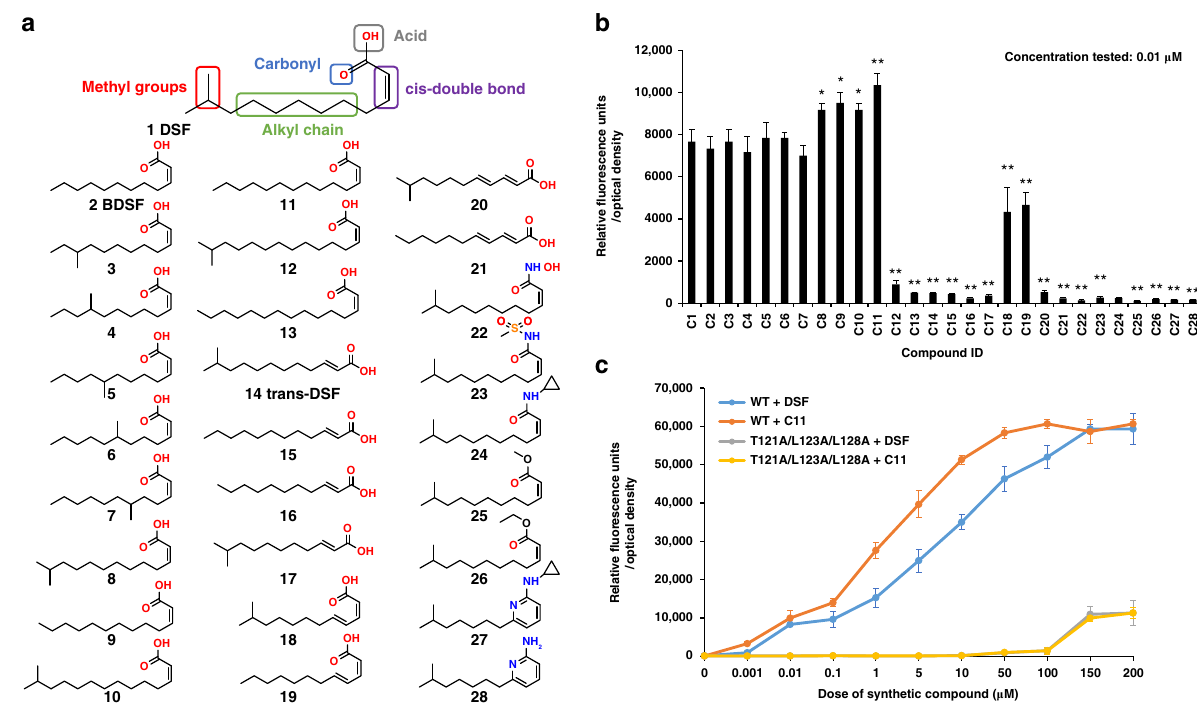
Fig. 2 Diffusible signal factor (DSF) analog testing reveals features needed for perception by PA1396. a The structure of DSF ( cis -11-methyl-2-dodecenoic acid) highlighting structural elements. Below this are the chemical structures of the 27 synthetic derivatives of DSF, all validated by ESI-MS and 1 H NMR spectra as described in the Methods. b The biological activity of DSF and its derivatives in activation of the pmr-gfp fusion. Samples were tested at a concentration of 0.01 µ M (the minimum concentration of cis -11-methyl-2-dodecenoic acid required for activation of the bioassay). Values are the average of three technical repeats (mean ± standard deviation). Asterisks indicate values that are signi fi cantly different from the appropriate wild type ( p < 0.05, Student's t- test). c Dose – response of DSF ( cis -11-methyl-2-dodecenoic acid) and C11 ( cis -2-tetradecenoic acid) on activation of pmr-gfp transcriptional fusion in wild-type PA1396 and a strain expressing the variant T121A/L123A/L128A with alteration in conserved amino acids of TMH-IV. The data of GFP fl uorescence shown is from one representative experiment ( n = 3). Differences seen between wild type and DSF, and mutant and DSF was statistically signi fi cant ( p- value < 0.05, ANOVA). Differences seen between wild type and C11, and mutant and C11 was statistically signi fi cant ( p- value <